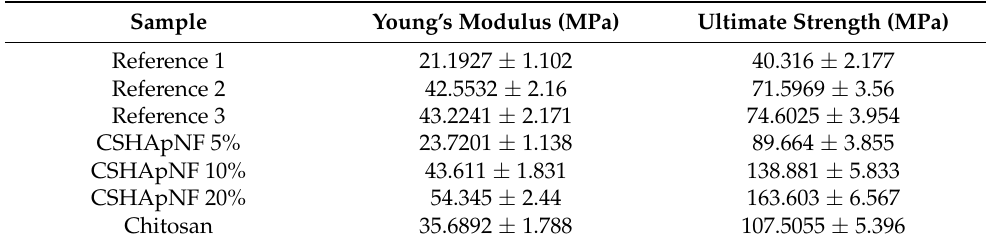
Table 3. Young’s modulus and ultimate strength average values obtained for all composite materials synthesized in this research study.